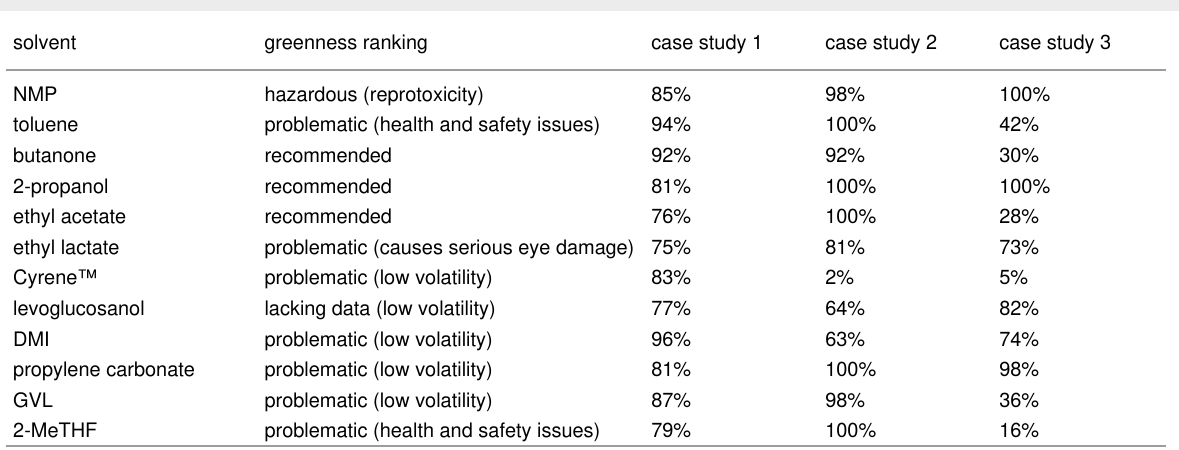
solvent greenness